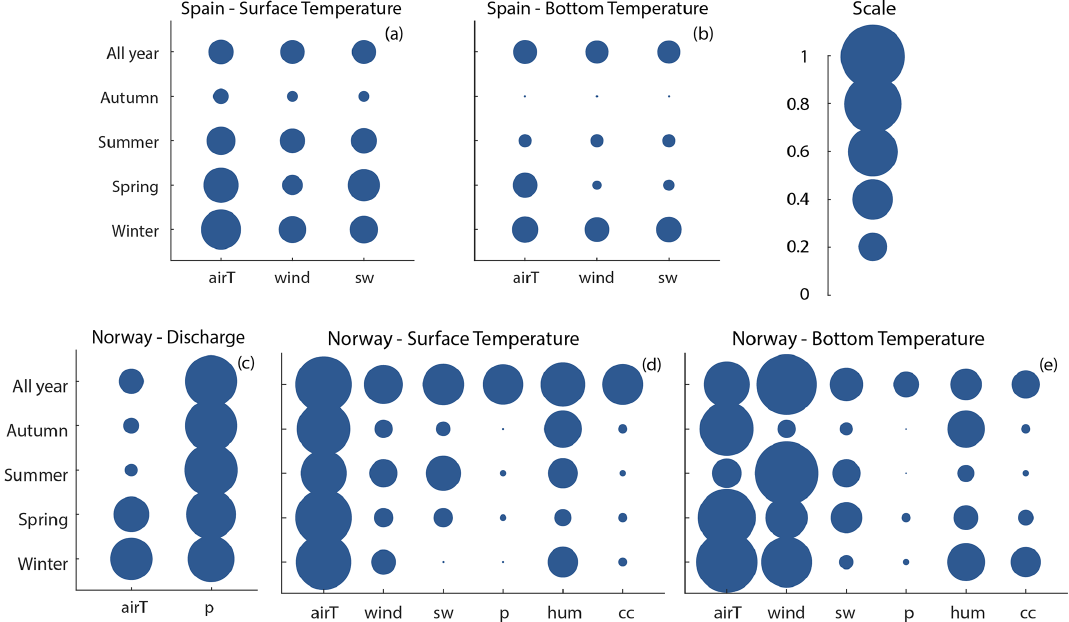
Figure 5. Relative sensitivity expressed as 1 − R 2 of Lake_PO seasonal means to specific input variables estimated following the OAT- SA (see Sect. 2.2.3 and Table 3 in the Methods section for details). Circle size represents relative sensitivity on a scale from 0 to 1; for example, larger circle sizes, i.e. higher (1 − R 2 ) values, indicate more influence of input variables on Lake_PO. The meteorological variable abbreviations, airT, P , wind, cc, hum and sw, stand for surface air temperature, precipitation, wind speed, cloud cover, relative humidity (or dewpoint temperature) and short-wave radiation, respectively. Note that the relatively larger sensitivity of Lake_PO to specific input variables over the whole year can be larger compared to over a given season because of the strong seasonal cyclicity. Note that the OAT-SA was only performed for Sau Reservoir in Spain and Lake Vansjø in